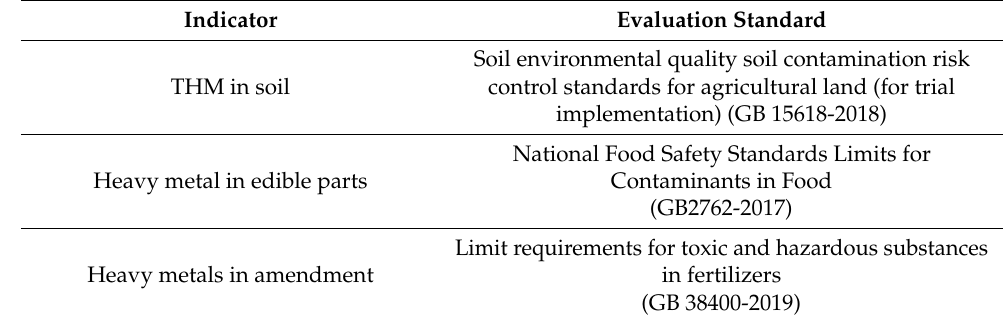
Table 4. The evaluation standards of Indicators